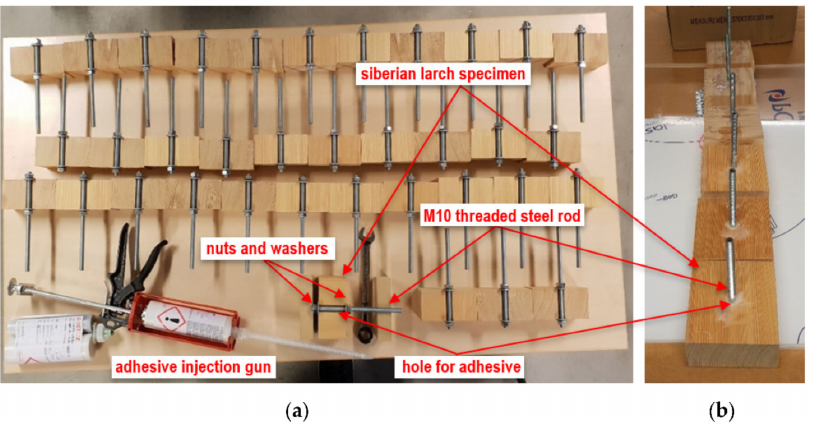
Figure 1. Preparation of bonded-in rod (BiR) connections with M10 steel rod (examples of polyurethane adhesive bonding): ( a ) half-size and ( b ) full-size specimens. Half-size specimens (with dimensions B = 120/ W = 60/ L = 60 mm) were drilled in their full height L with a concave-notch diameter equal to d h = 14 mm. This hole was placed at the centre of the cross-section of each timber log, in order to introduce both the rod and the adhesive bond. Standard type specimens were characterized by double size (with dimensions B = 120/ W = 120/ L = 60 mm) and prepared with a similar approach. Each timber log was drilled in the full height (60 mm), and a d h = 14 mm hole was drilled at the centre of the wood cross-area.